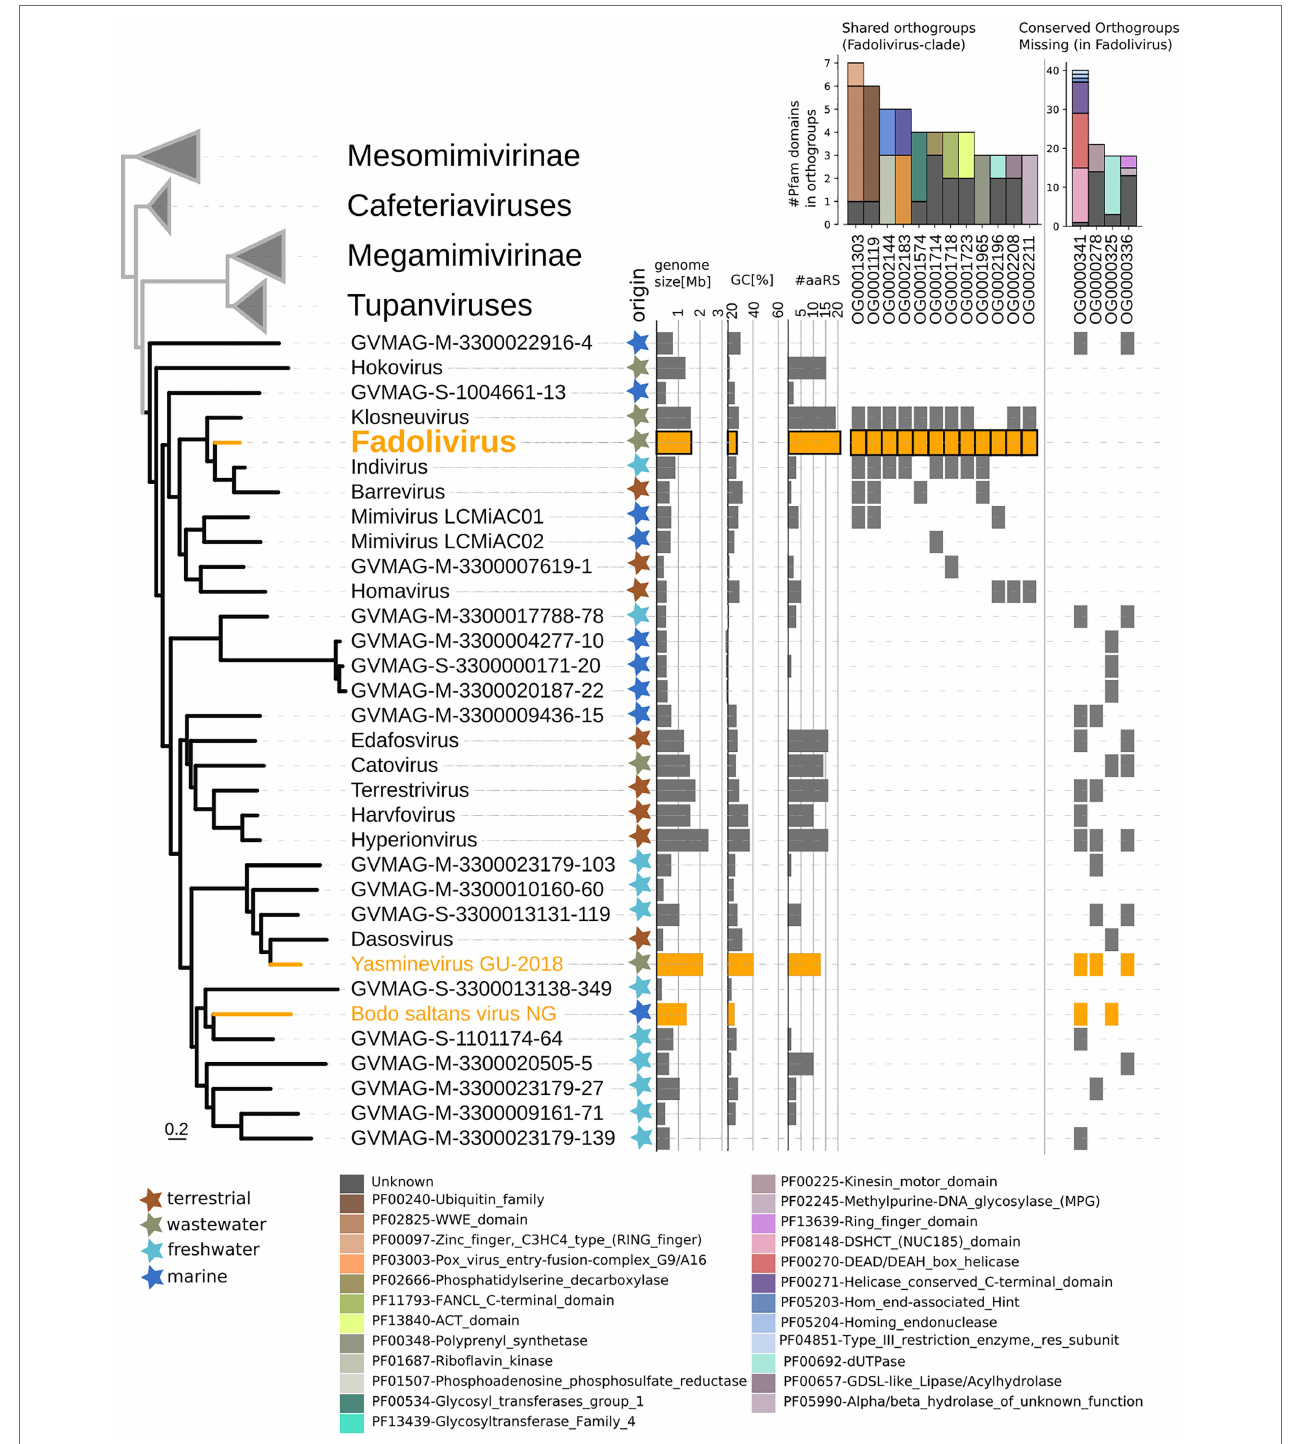
FIGURE 5 | Phylogenetic position of Fadolivirus in the Mimiviridae and genome features. Maximum-likelihood phylogenetic tree (IQ-tree LG + F + R6) of the Mimiviridae inferred from a concatenated protein alignment of five core nucleocytoplasmic virus orthologous genes (NCVOGs; Yutin et al., 2009). Branches in orange represent viral isolates, and branches in black represent previously published metagenome-assembled genomes. The tree is rooted at the proposed viral subfamily Mesomimivirinae. Colored stars next to the tree indicate environmental origin. Bars next to the tree show genome features such as genome size, GC content and total number of proteins that contain aminoacyl-tRNA synthetase (aaRS)-related Pfam domain. Further, the presence/absence matrix next to the tree indicates protein families